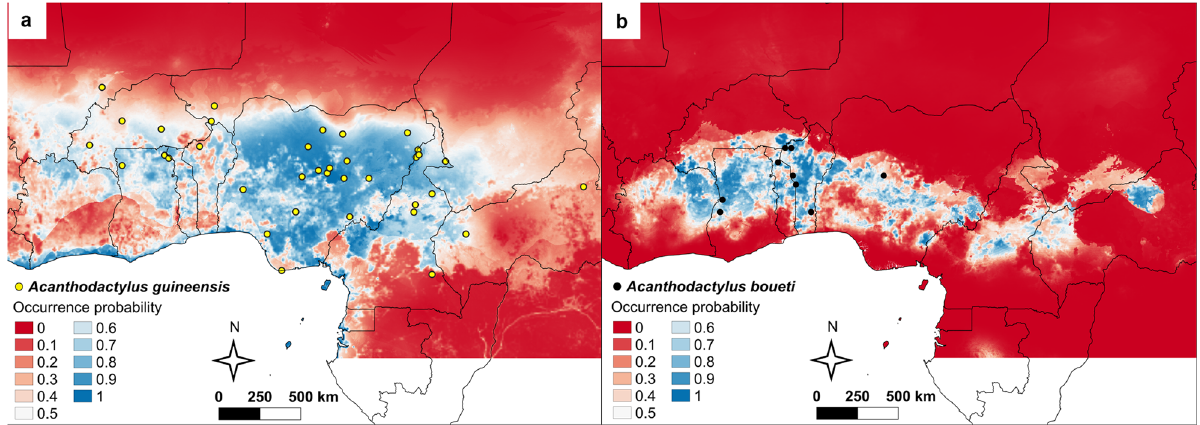
Figure 5. ( a , b ) Maxent model showing occurrence probabilities (higher with colder colors) of A. guineensis ( a ) and A. boueti ( b ) based on environmental parameters (i.e., Grinnellian niche). Areas in white were not modeled. The figure was created using QGIS 3.14.16 (https:// www. qgis. Côte d’Ivoire in the West, and central Nigeria, central Cameroon and parts of Central African Republic (Fig. 5b, Supplementary Figs. S5b, S6, S7 online).